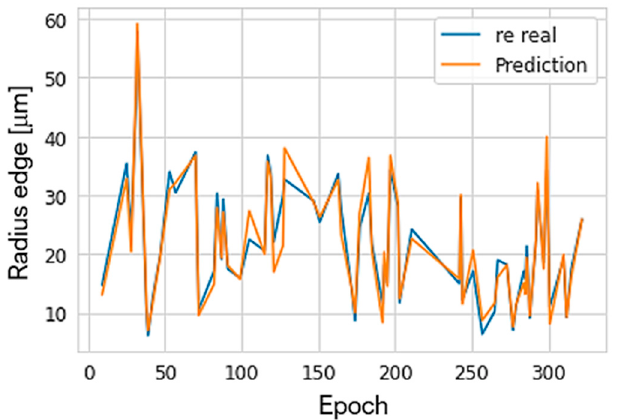
Figure 15. Comparison of the experimental radius with that predicted by ANN .